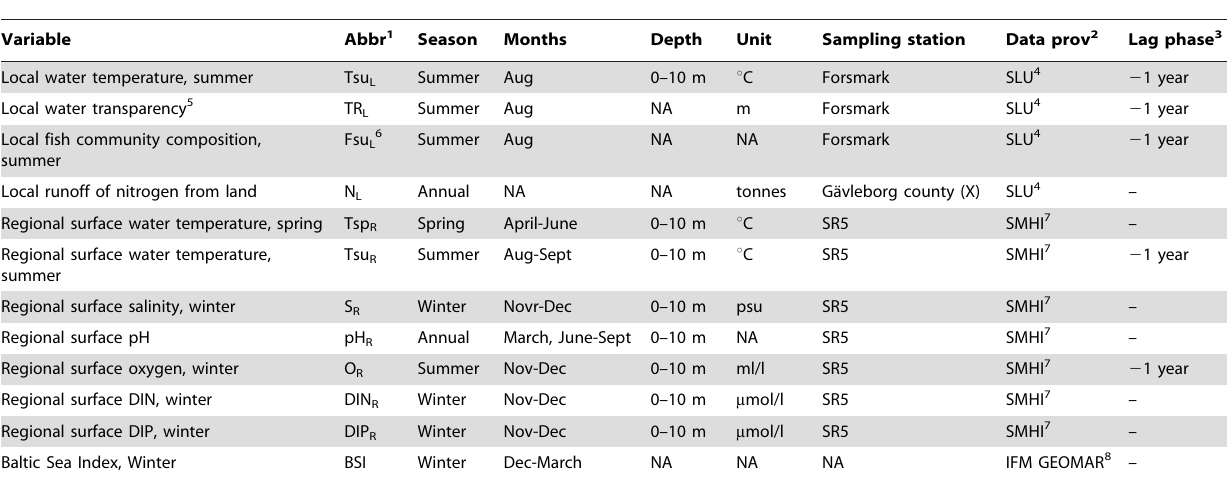
Table 3. The variables used as predictors for the temporal development of zoobenthos communities in Forsmark.